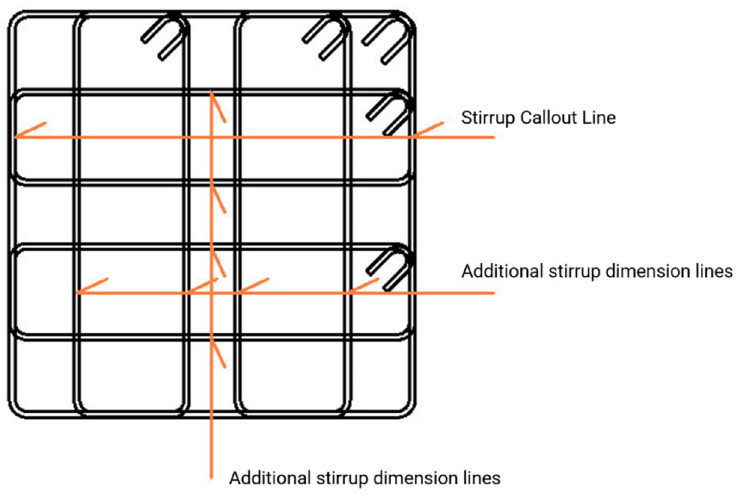
Figure 9. Schematic diagram of the rebar dimension line.